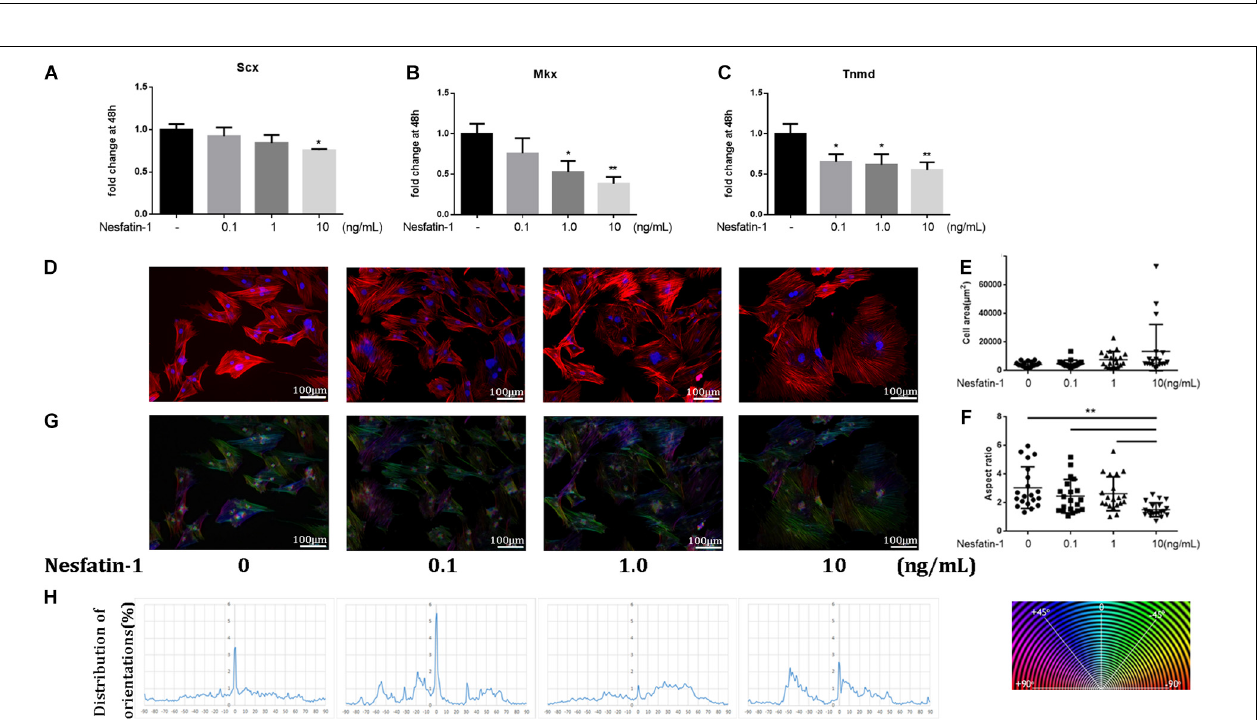
FIGURE 3 | Effect of Nesfatin-1 on TDSCs phenotype maintenance and cytoskeleton. (A–C) TDSCs were treated with different concentrations of Nesfatin-1 for 48 h. The mRNA levels of SCX, Mkx, and Tnmd were evaluated via qRT-PCR. (D) The TDSCs were treated with different concentrations of Nesfatin-1 for 24 h. The actin cytoskeleton organization was analyzed by phalloidin staining. F-actin stained in red and cell nuclei in blue. (E,F) Quantitative analysis of cell surface area and aspect ratio (major cell axis/minor cell axis) with ImageJ software. (G,H) OrientationJ plug-in for ImageJ was used to analysis the arrangement of stress fibers. The values are expressed as the mean ± standard deviation (SD). * p < 0.05, ** p < 0.01 vs. control group. Scale bar, 100 µ m.